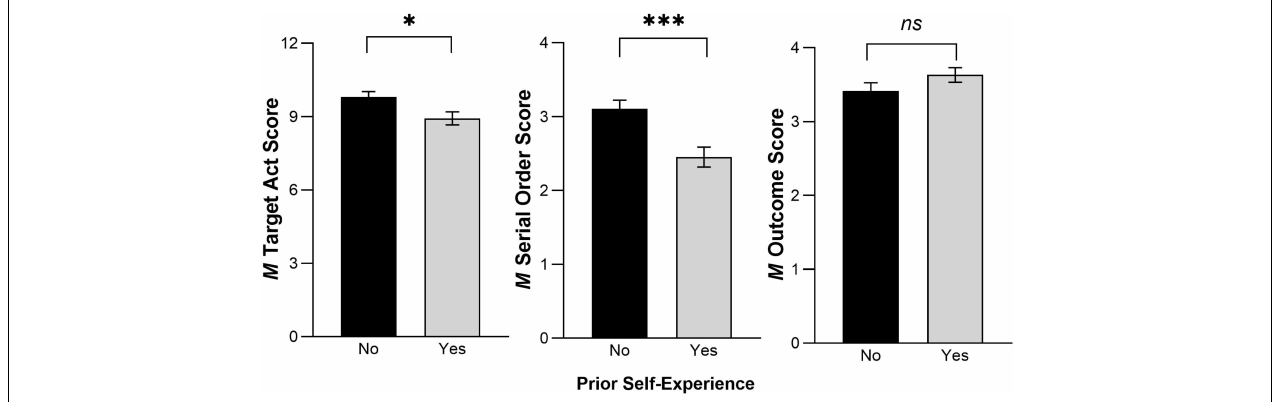
FIGURE 3 | Children’s responses as a function of having or not having prior self-experience for each dependent measure. Error bars show ± 1 SE. ∗ p < 0.05, ∗∗∗ p < 0.001.